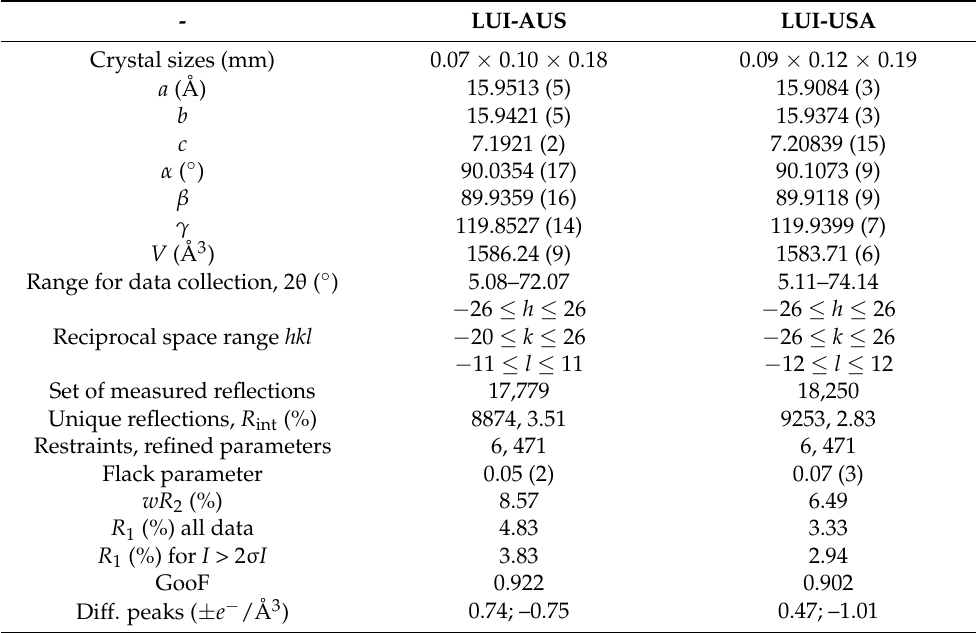
Table 3. Single crystal X-ray diffraction data details for luinaite -( OH ). - LUI-AUS